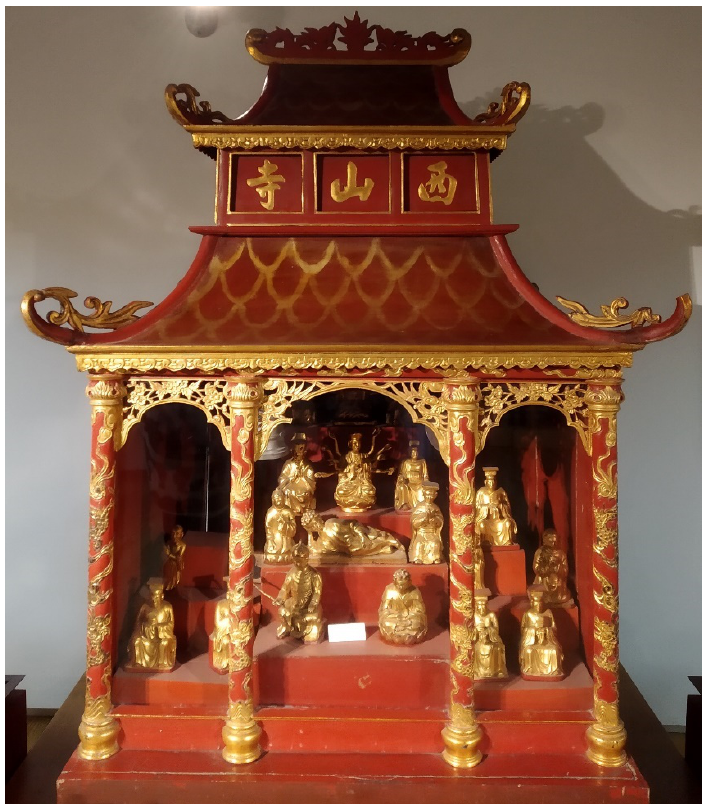
Figure 2. Domestic altar, Vietnam, 19th century. Museo de Arte Oriental, Ávila. Photo: Alberto